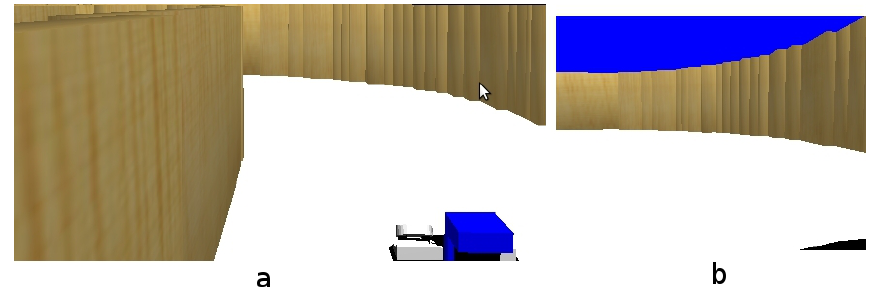
Figure 13. ( a ) Situation; ( b ) Current onboard image.